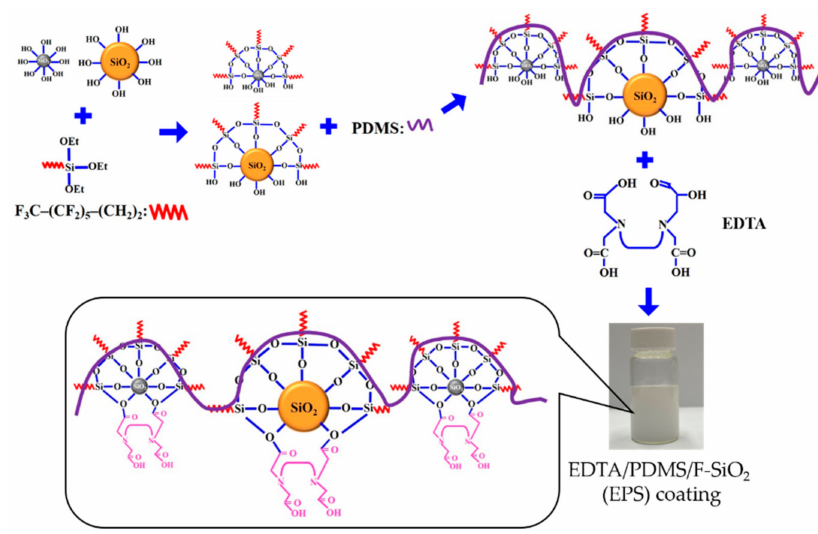
Figure 1. Schematic illustration of the EPS composite coating solution